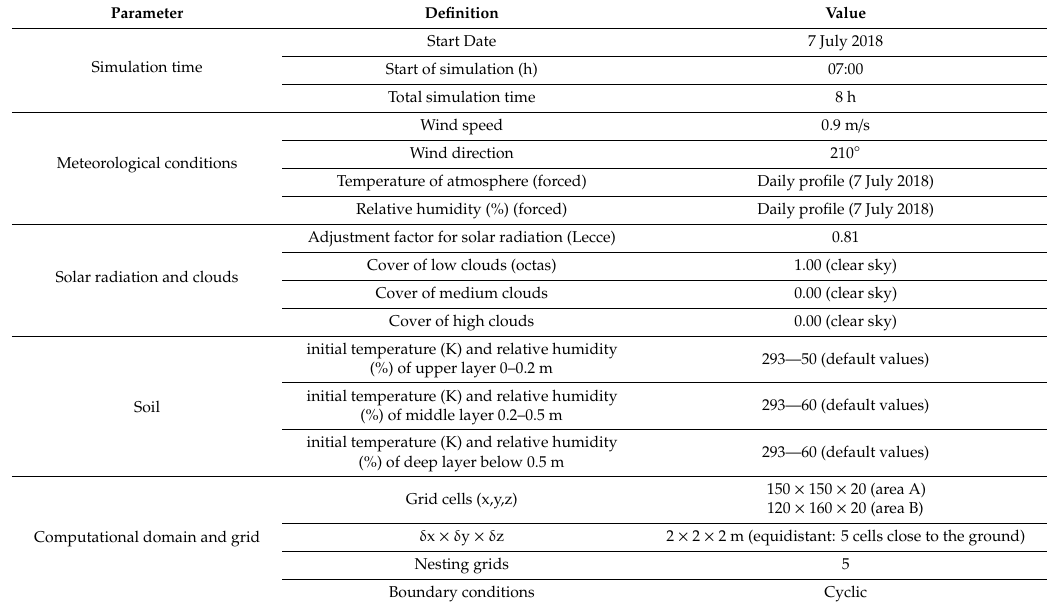
Table 3. Initial and boundary conditions used in ENVI-met simulations of Solutions 1 and